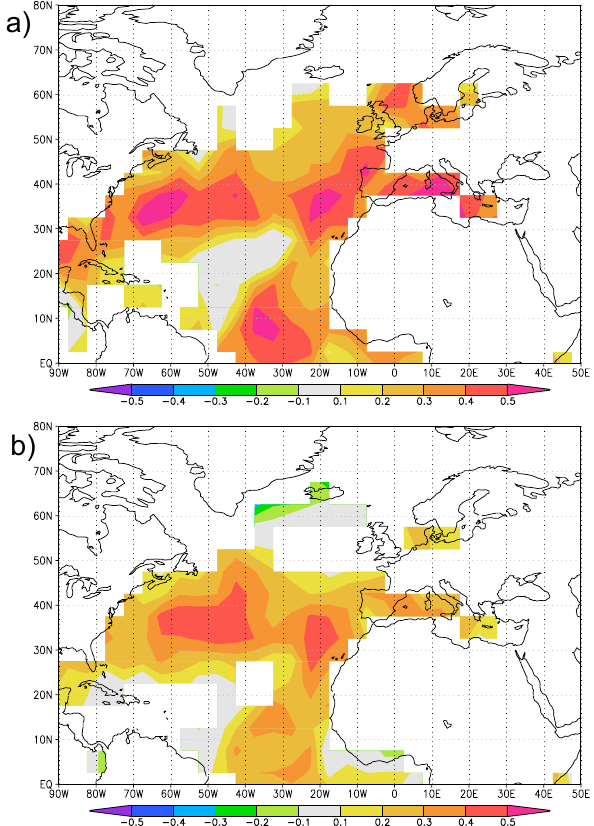
Fig. 7. As Fig. 6, but for δ 18 O precip instead of the SST